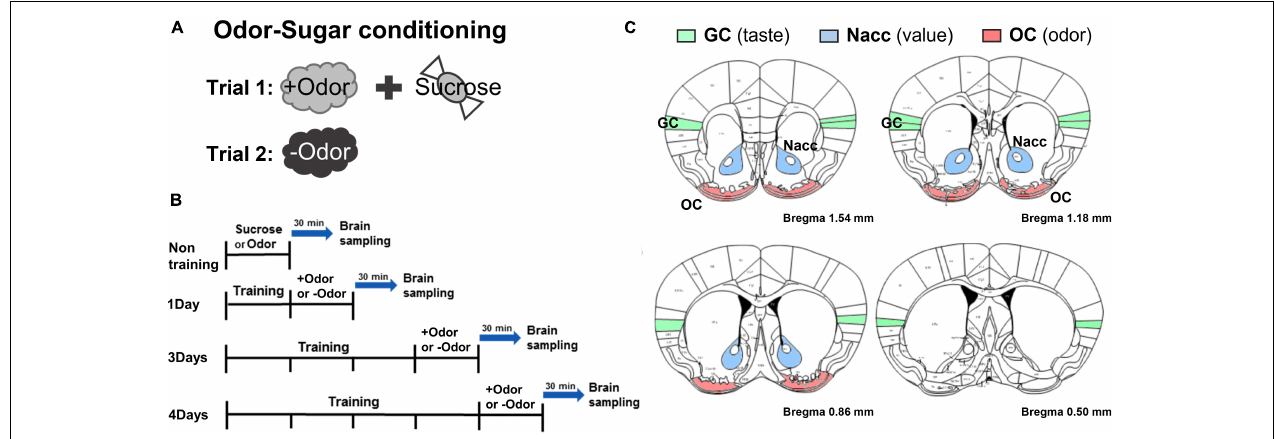
FIGURE 1 | Experimental timeline to examine conditioned stimulus (CS)-evoked neural activation over the 4-day course of odor-sugar conditioning. (A) Odor-sugar conditioning. After 2 days of habituation to sugar pellets, a single olfactory training session (trial 1: +Odor → sugar pairing; trial 2: –Odor without sugar) per day was given for various training days. (B) Brain sampling. Subjects were divided into non-training, 1Day, 3Days, and 4Days group. The non-training group was exposed to sugar or an odor and 1Day, 3Days, and 4Days group were exposed to +Odor or –Odor on the day after the last training session and then sacrificed 30 min later. (C) Schematic representation of the gustatory cortex (GC), the nucleus accumbens (Nacc), and the olfactory cortex (OC) region in mice (bregma 1.54–0.50 mm) (The Mouse Brain in Stereotaxic Coordinates, 2nd edition, by George Paxinos and Keith BJ